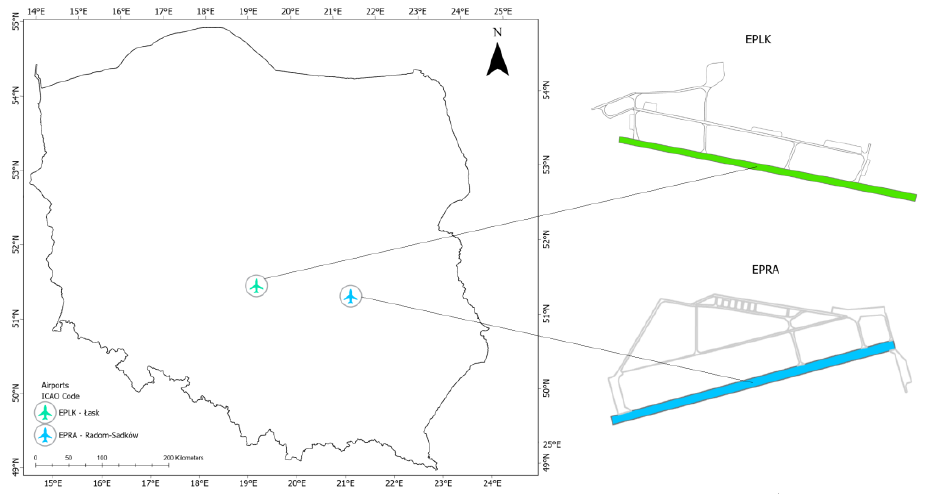
Figure 7. Location of the research